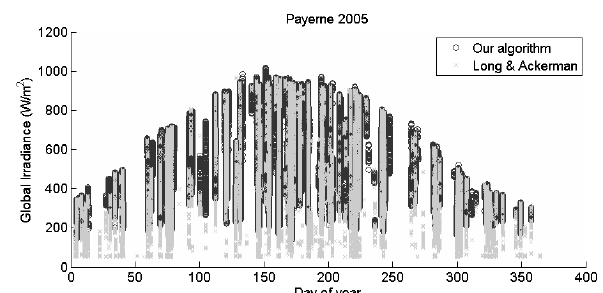
Fig. 3. Time series of Eglo for the selected clear-sky instants in the year 2005 in Payerne, in black circles. Clear-sky instants selected by the algorithm of Long and Ackerman (2000) are in light-grey